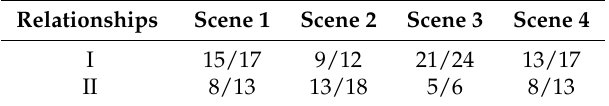
Table 4. FTCs in different ROIs of four tests and final similarity